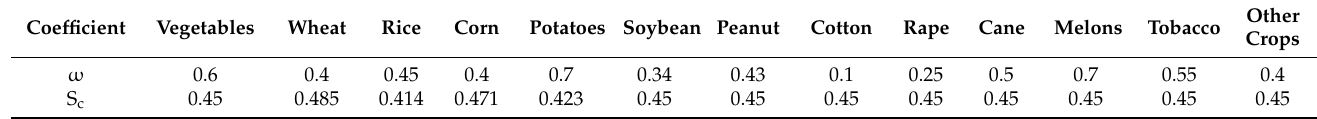
Table 3. Crop economic coefficient and carbon absorption rate (unit: ton carbon/ton).